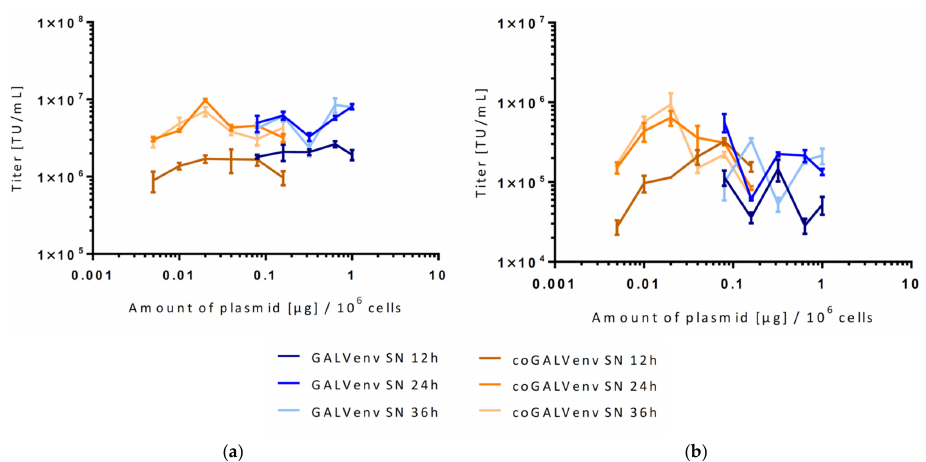
Figure 3. Titers of ( a ) γ - and ( b ) α -retroviral vectors produced with GALV-env or coGALV-env as determined on 293T cells. For transient vector production, the following plasmid amounts per 10 6 producer cells were used: GALV-env: 1 µg, 0.64 µg, 0.32 µg, 0.16 µg and 0.08 µg, coGALV-env: 0.16 µg, 0.08 µg, 40 ng, 20 ng, 10 ng, and 5 ng of plasmid. Data points shown represent means of triplicates. SN = supernatant, TU = transducing units.